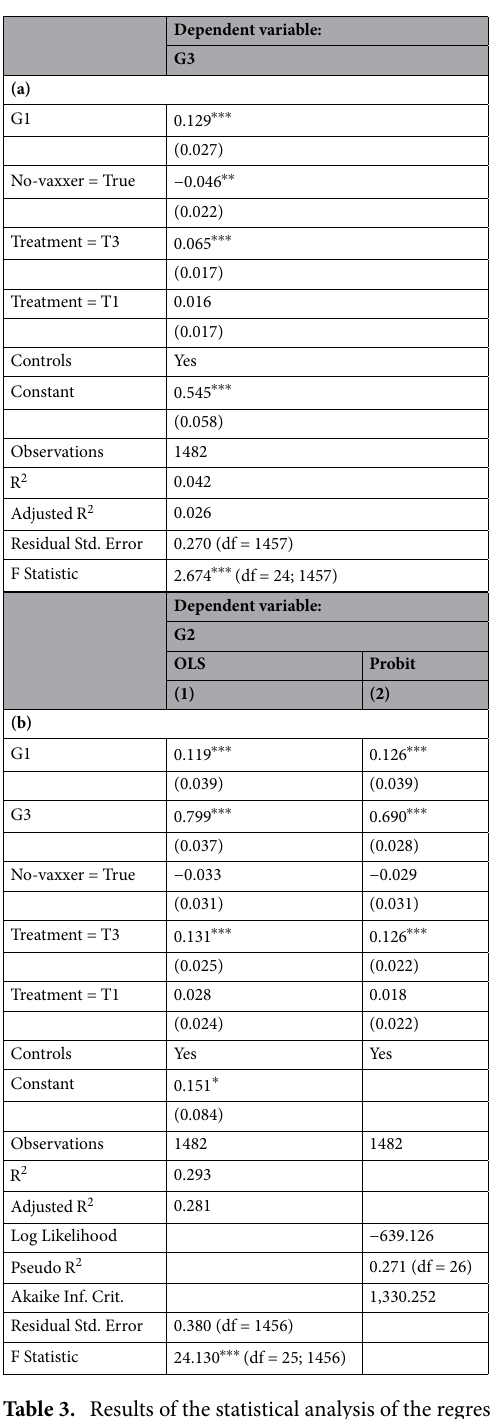
Table 3. Results of the statistical analysis of the regression Eqs. 1 and 2. ∗ p < 0.1; ∗∗ p < 0.05; ∗∗∗ p < 0.01. (a) OLS model of regression 1 of the form G3 ∼ G1 + No-vaxxer + Treatment + Controls. Controls include age and region. Standard errors in parenthesis. (b) OLS and Probit model of regression 2 of the form: G2 ∼ G1 + G3 + Treatment + Controls. Coefficients of ordinary least square in column 1 and average marginal effects of Probit in column 2. Controls include age and region. Standard errors in